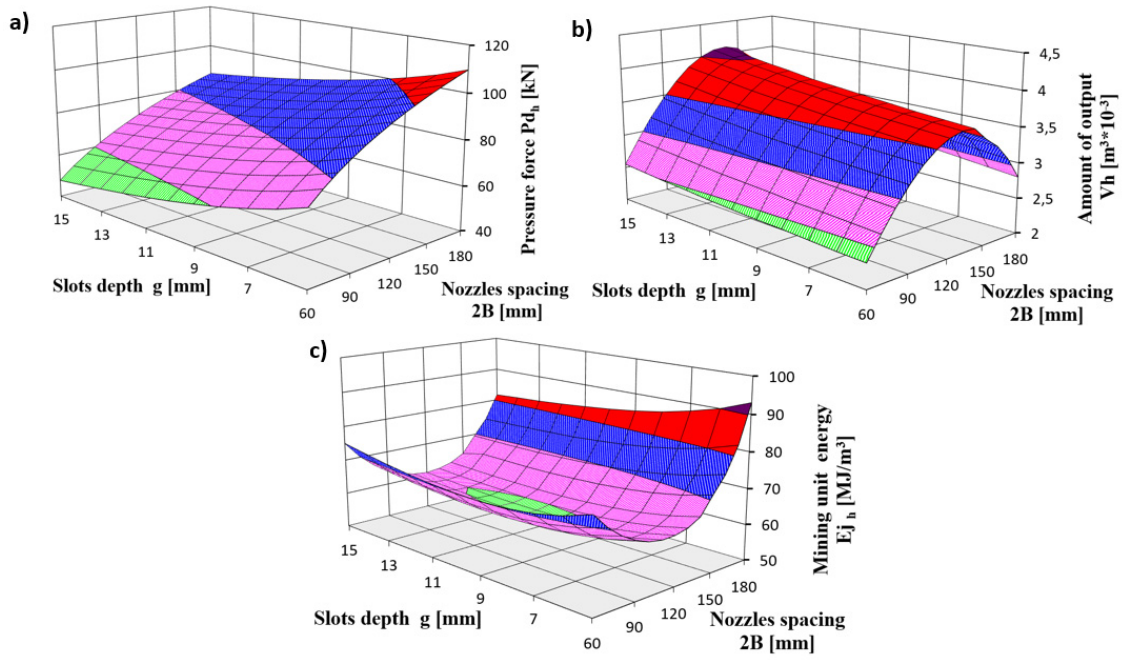
Figure 20. The value of the pressure force Pd ( a ), the amount of output V ( b ) and the mining unit energy Ej ( c ) for mining with the disk tool with HPW jets assistance as a function of slots spacing 2B and depth of slots g; disk edge angle 2 β = 130°; disk edge penetration depth h = 10 mm; mining radius R u = 350 mm; sample compressive strength R c = 14.5 MPa [1] .